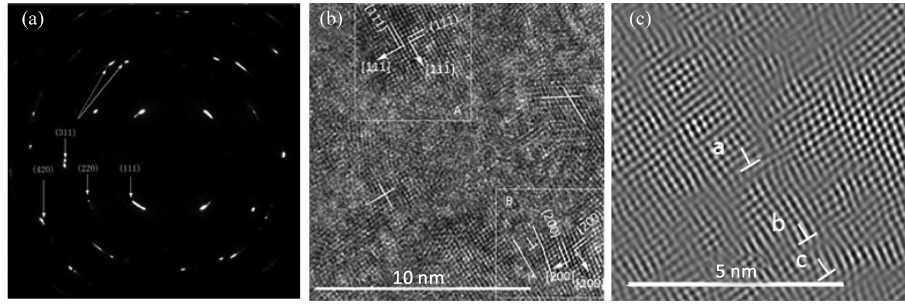
Figure 9: SAED patterns and deformation microstructures of Ni20Cr micro-wires with engi- neering strain of 46.6% in wire cross section by TEM.